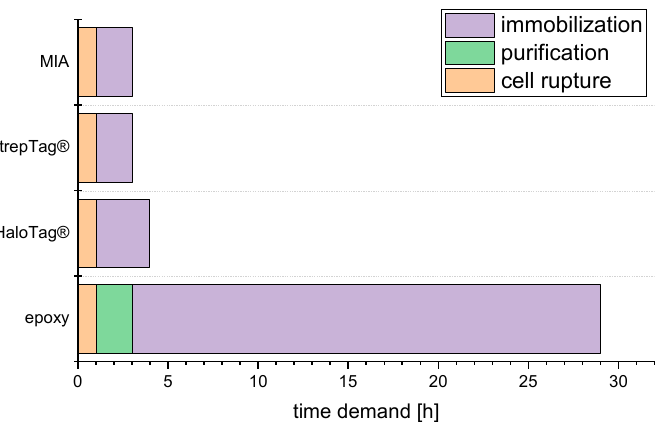
Figure 4. Time demand for reactor preparation of investigated immobilization approaches. MIA: metal ion affinity.